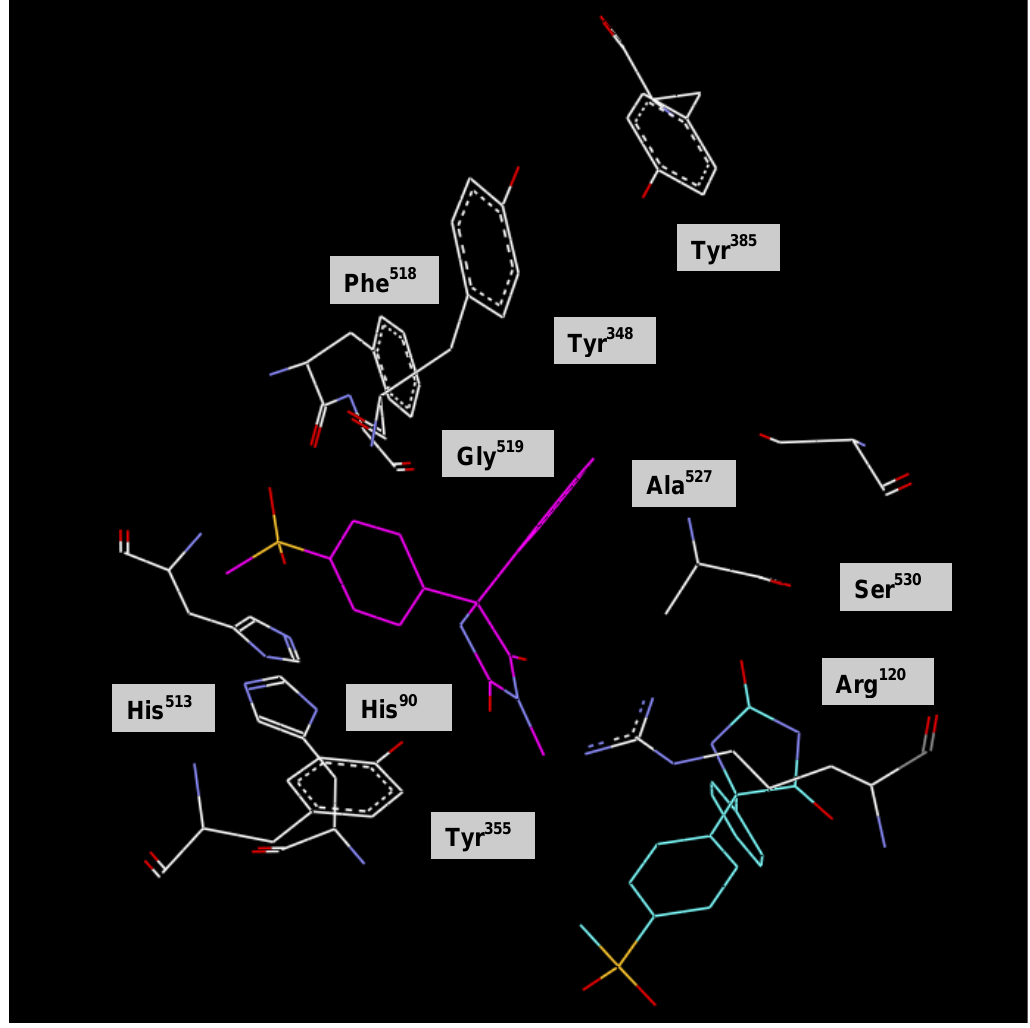
Fig. 3. Docking of 4 (in blue) and 5 (in pink) in the active site of murine COX-1. 1-[4-(Methylsulfanyl)phenyl]-2-phenylethanone ( 1 ) Phenacetyl chloride (4 ml, 30.2 mmol) was added to a suspension of anhydrous aluminum chloride (4.2 g, 31.6 mmol) in dry dichloromethane (50 ml) under argon atmosphere